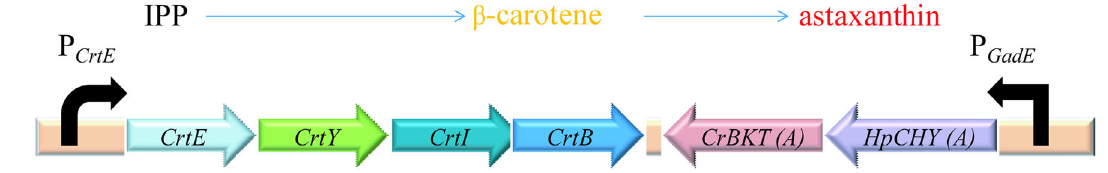
Fig. 3 Schematic diagram of the plasmid pCm- GadE p-